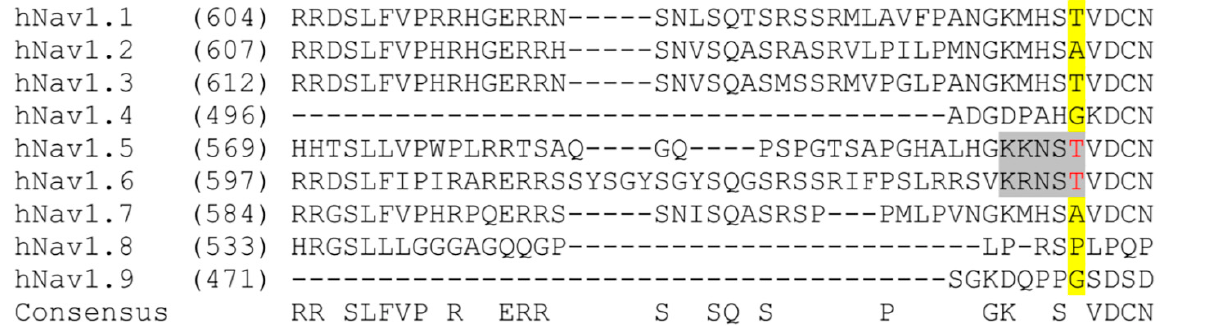
Figure 4. Nav1.6 protein sequence alignment spanning position 642 (yellow) in L1 region of the channel. The T642 site (red) within the CaMKII phosphorylation motif (gray) is only present in human isoforms Nav1.5 and Nav1.6.